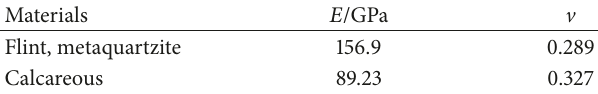
Table 9: Mechanical parameters of the